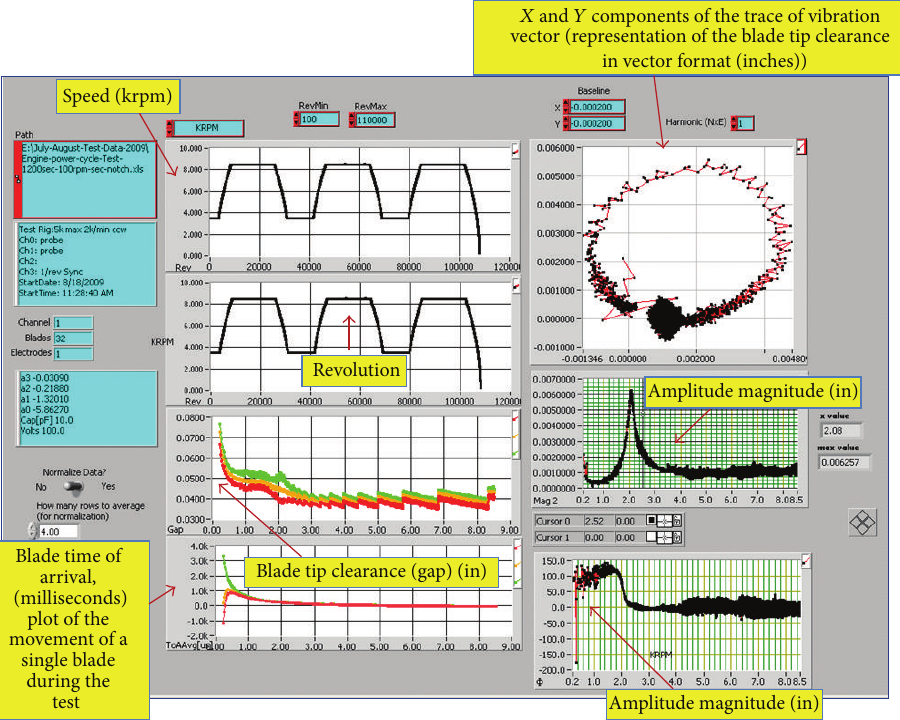
Figure 6: Engine constant power cycle test: capacitive sensor data at 8500 rpm, 1200sec long at 100rpm acceleration/deceleration rate for the Notched disk.